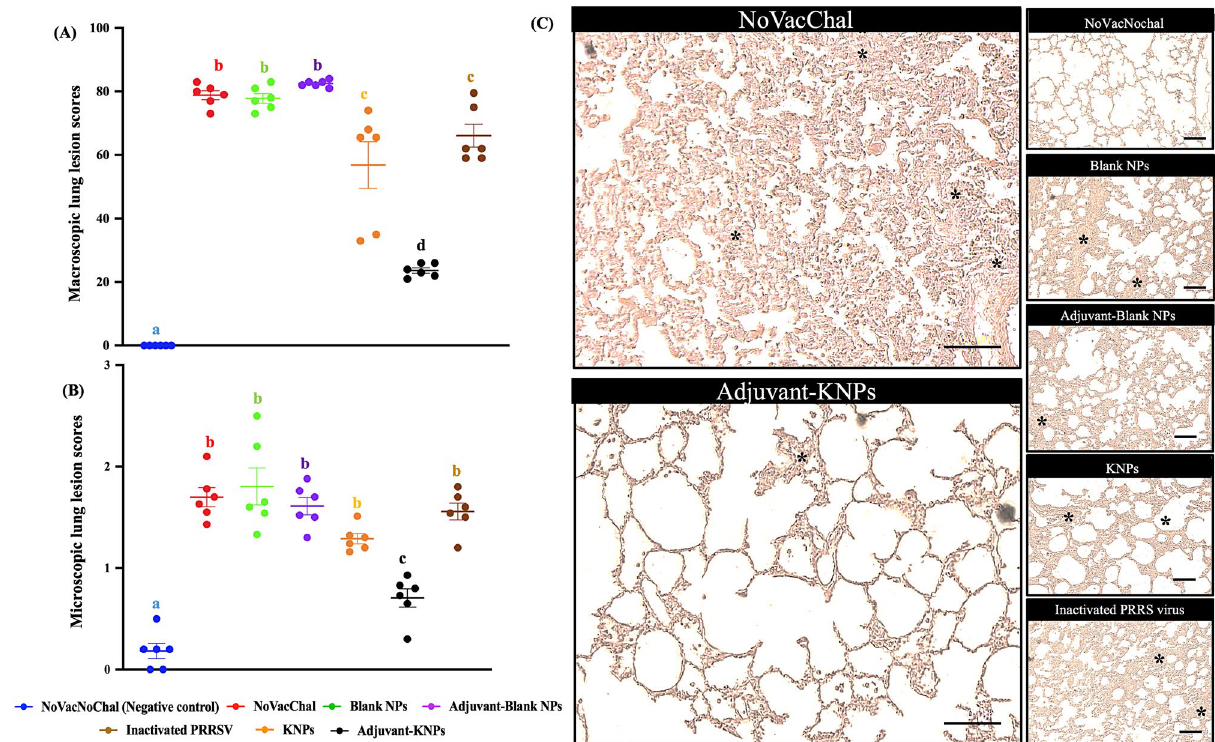
Figure 8. Lung lesion scores at 7 days post-challenge. ( A ) Macroscopic lung lesion scores, ( B ) microscopic lung lesion scores and ( C ) H&E images of microscopic lung lesions from challenge pigs. Different lowercase letters indicate significant differences between groups ( p < 0.05). *Histopathology of lungs with pneumocyte